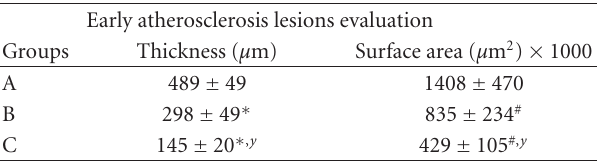
Table 5: Assessment of early atherosclerosis lesions observed in rab- bit